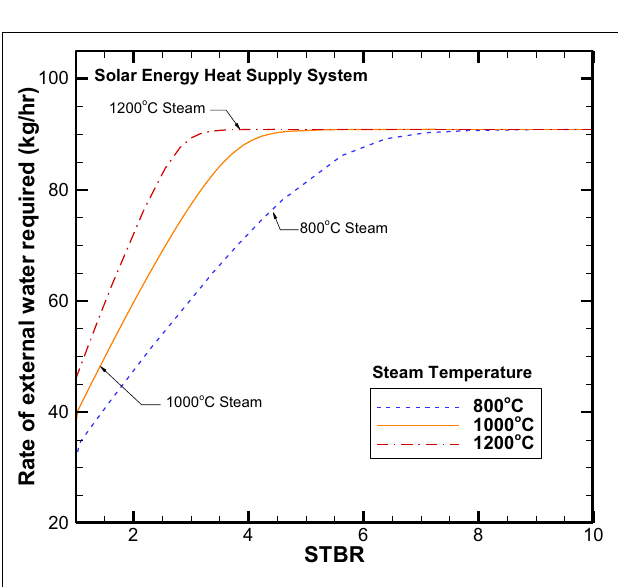
FIGURE 15 | Efficiencies for concept system II as a function of STBR